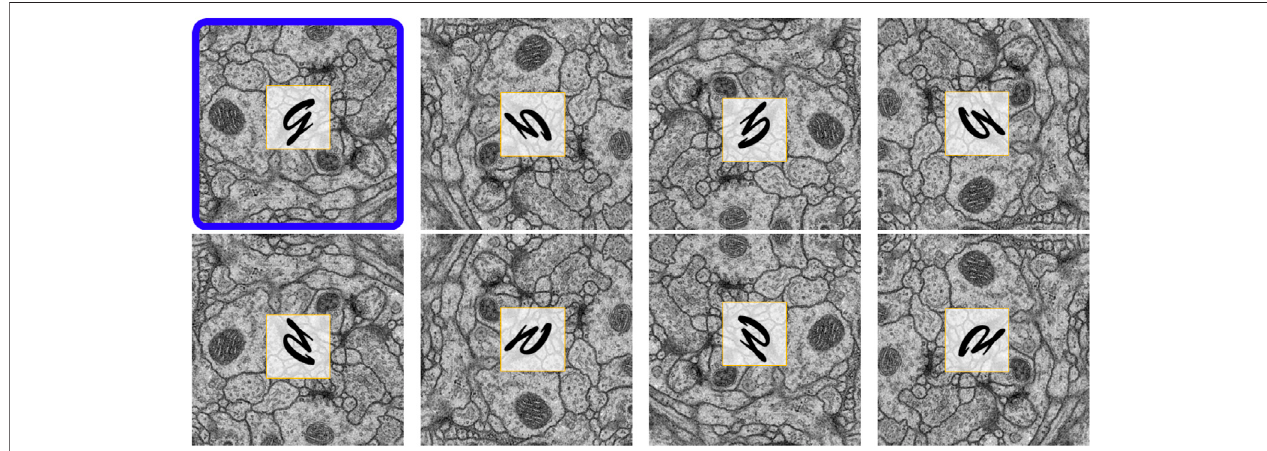
FIGURE 4 | Eight reoriented versions of the same EM image. The original image is outlined in blue. By adding these reoriented images, the input data size is increased by eight times.